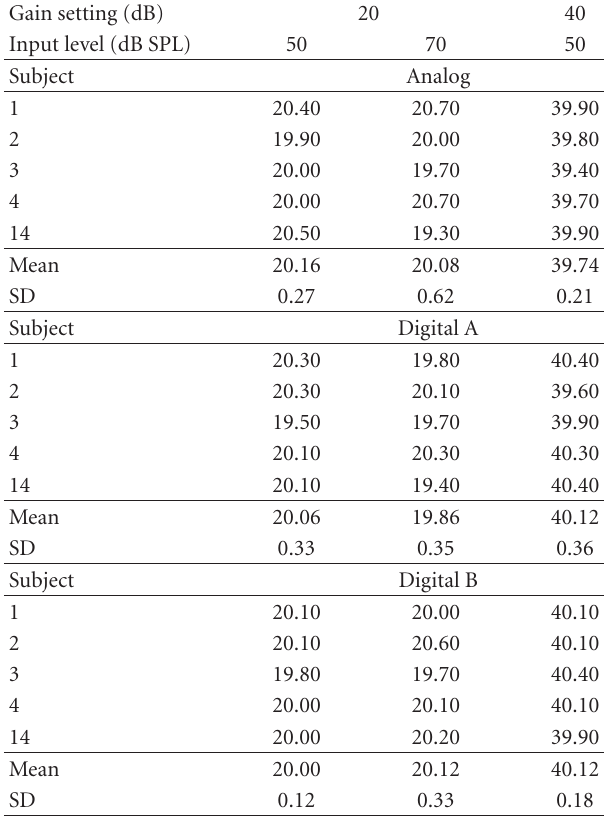
Table 1: Real-ear insertion gain (REIG) (dB) measured with a hear- ing aid test system for 20 and 40 dB gain